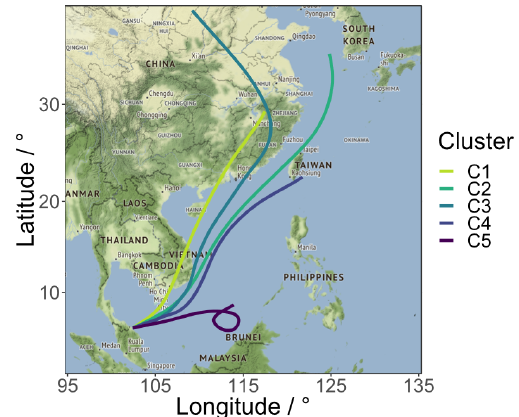
Figure 7. Five-cluster solution to backward air mass trajectories centred on the Bachok research station between 18 January and 7 February